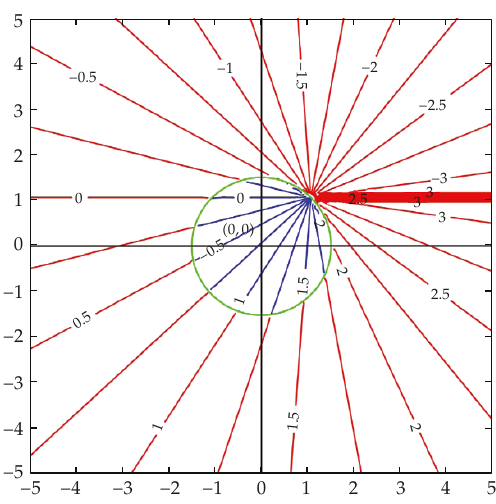
Figure 4: Screw dislocation in the first quadrant after modification (cid:5) R (cid:4) 1 . 5, θ (cid:4) π/ 4 (cid:6) .